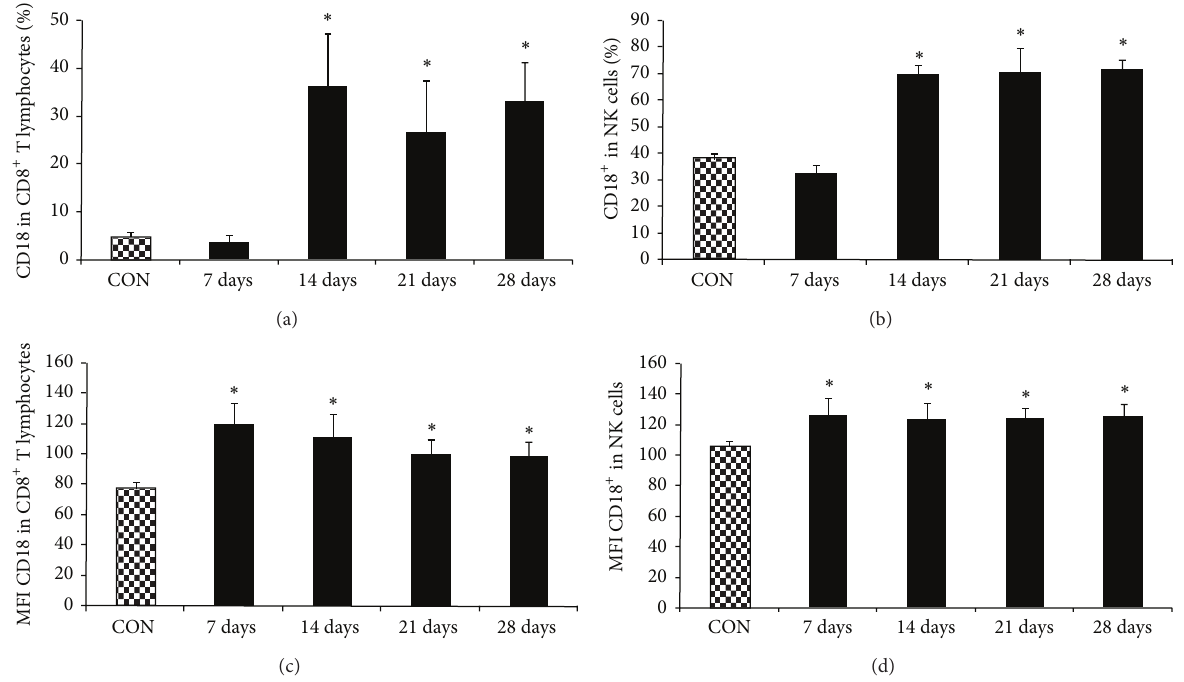
Figure 2: CD18 expression in CD8 + T lymphocytes and NK cells from rats with nephrotic syndrome induced by doxorubicin and control animals in ex vivo condition. Blood leukocytesin rats ( 𝑛 = 32 ) that received a single dose of doxorubicin in the tail vein (7.5mg/kg) and control rats ( 𝑛 = 32 ) that received PBS in the same condition were stained ex vivo for CD18 and CD8 expression. Data were collected using flow cytometry and analyzed using CellQuest software. Graphs (a) % of CD18 + CD8 + , (b) % of CD 8 low + CD 18 + , (c) MFI of CD18 + CD8 + , and (d) MFI of CD 8 low + CD 18 + show expression of the given marker in lymphocytes. The data expressed as mean ± standard error for Dox group (black bars) and control group (grew bars). ∗ 𝑝 < 0.05 for the comparison between Dox and control group at the same time-point (Student’s 𝑡